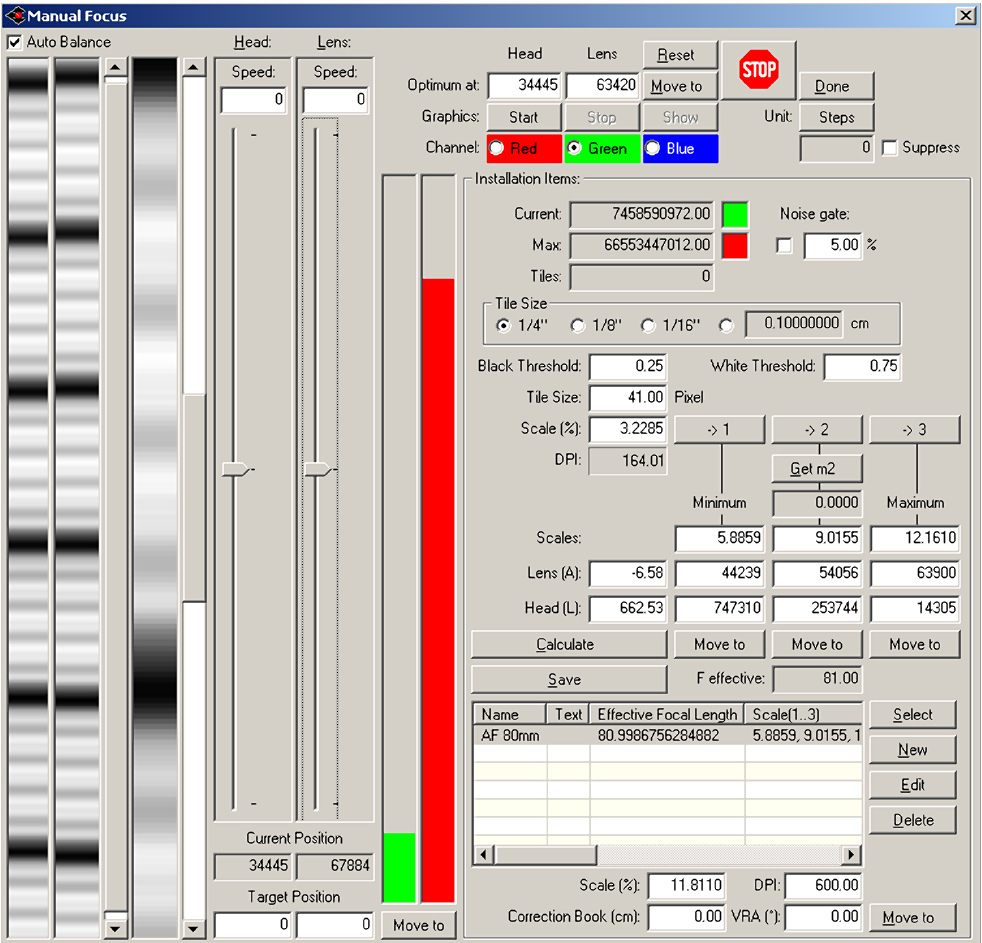
Figure 7. Cruse manual focus dialog for the unfocused